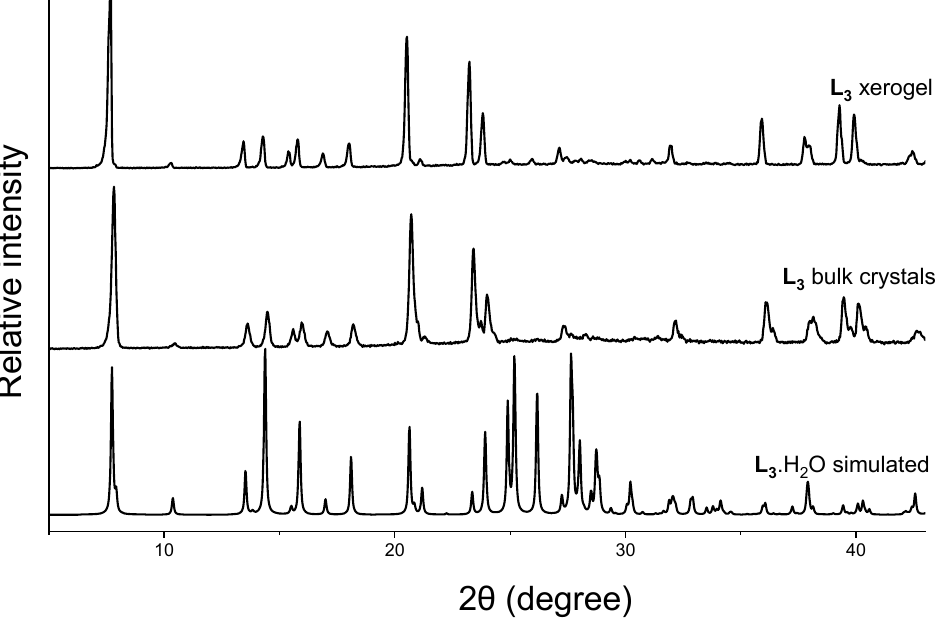
Figure 4. Comparison of the simulated pattern from single-crystal X-ray structure of L 3 • H 2 O with the PXRD pattern of the bulk crystals obtained from water and xerogel from water at 2.0 wt%.